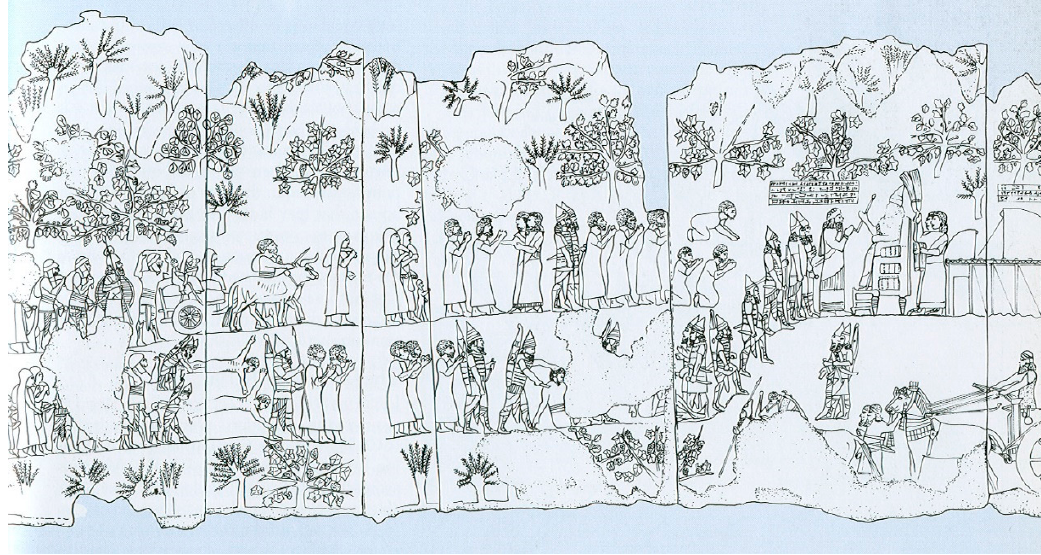
Figure 1. Agricultural hinterland outside the city Lachish, Lachish relief, Sennacherib’s castle at Ninveh.